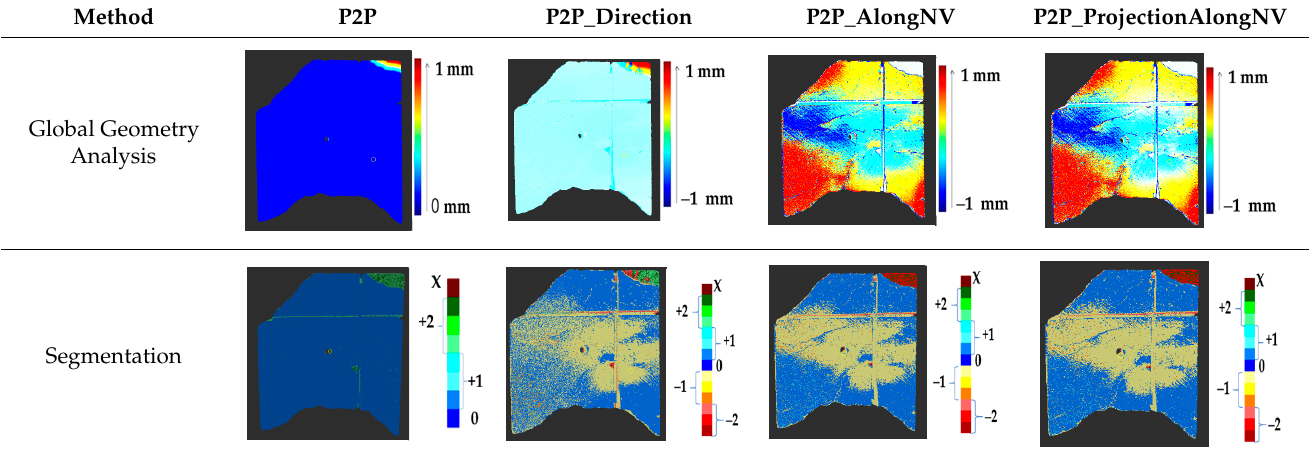
Table 17. Analysis and results for the dataset of NBL1.